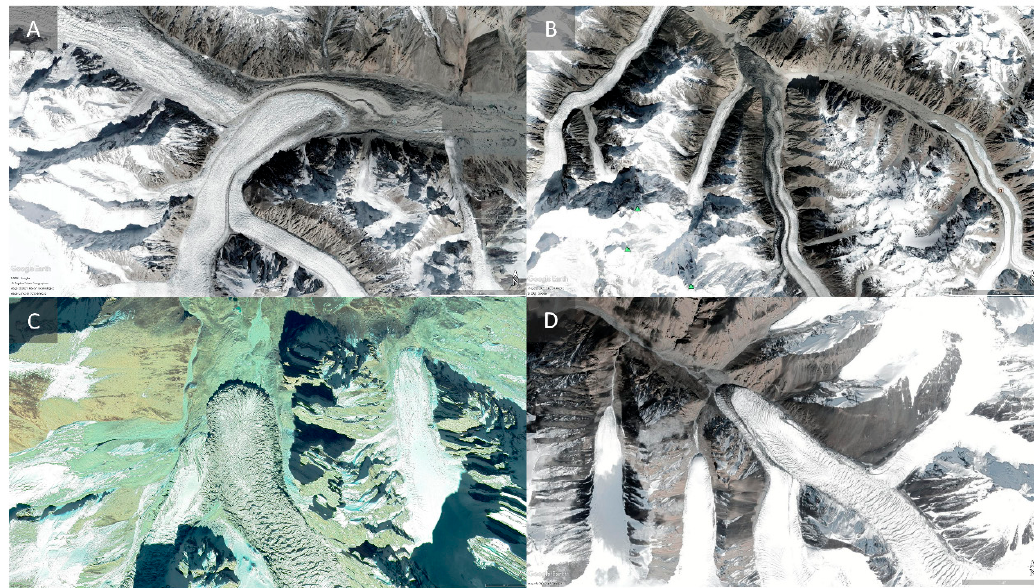
Figure 3. Examples of surge-indicative features from Google Earth Satellite Imagery. ( A ) Looped moraine at Glacier K13, Sugatyanatjilga Glacier, ( B ) Unstable moraine at Khurdopin Glacier, ( C ) Bulbous terminus at Glacier WKS4, RGI60-13.38961, ( D ) Enhanced crevasses at Glacier K53, RGI60-14.02215.